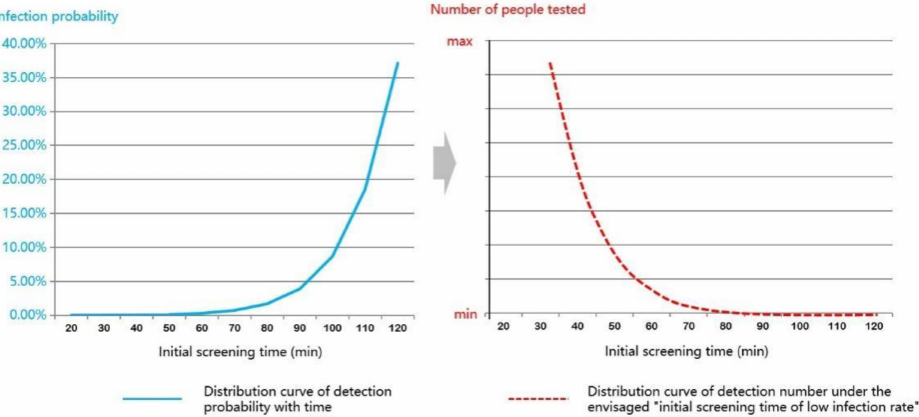
Figure 2. Distribution of infection rate and times of patients in virus testing time of 20–120